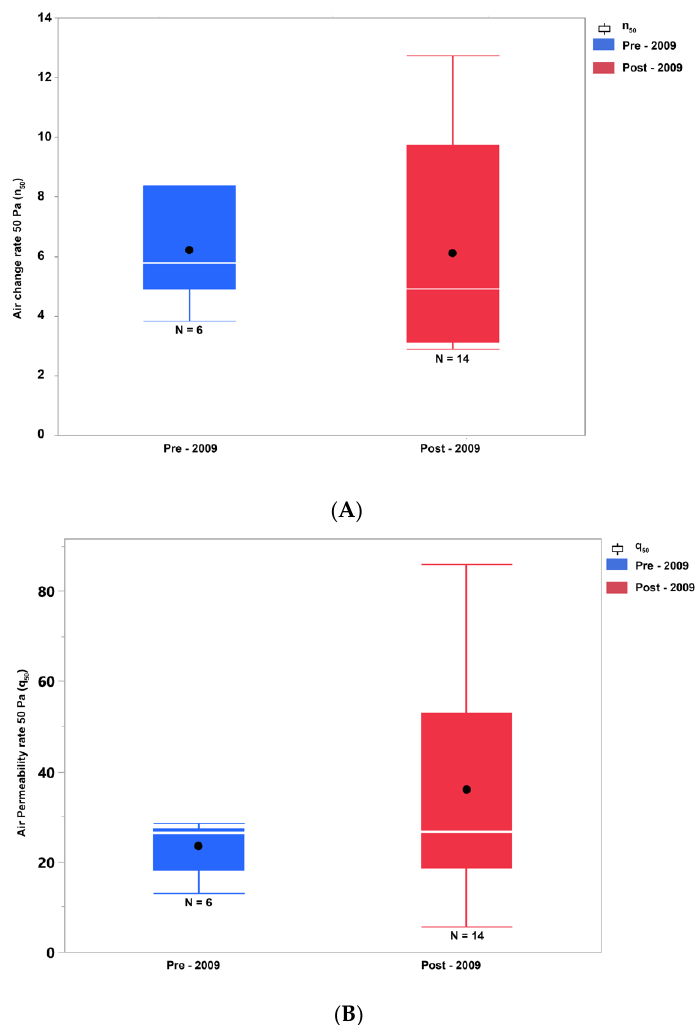
Figure 9. Box and whisker plots showing the distribution of ( A ) n 50 and ( B ) q 50 for dwellings constructed before and after 2009 (black dots show the mean value).